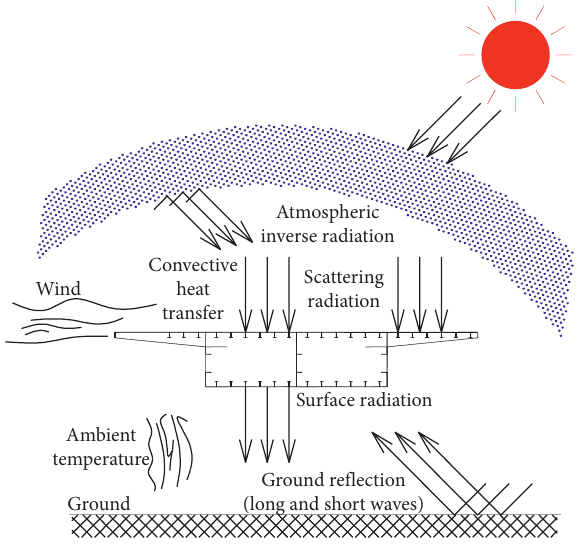
Figure 5: Heat exchange process between steel box girder and